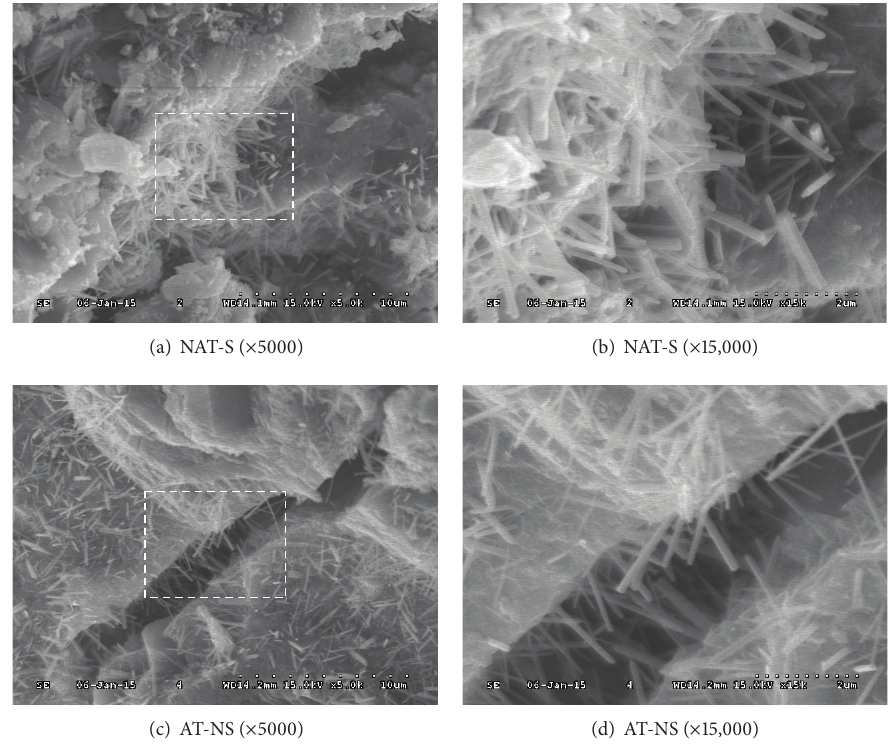
Figure 11: Representative SEM images taken from NAT-S and AT-NS